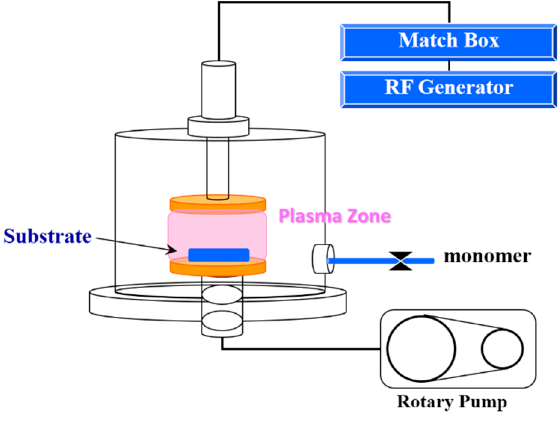
Figure 1. Schematic diagram of the plasma treatment system.